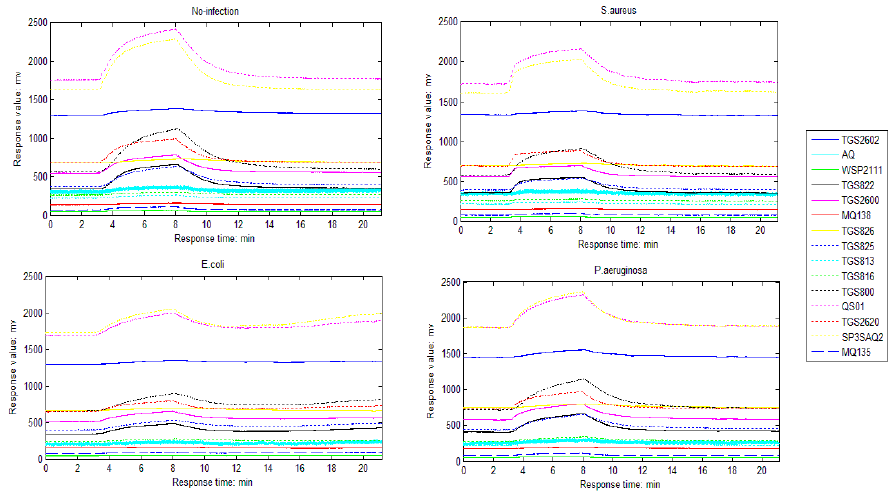
Figure 2. E-nose response to four wounds.